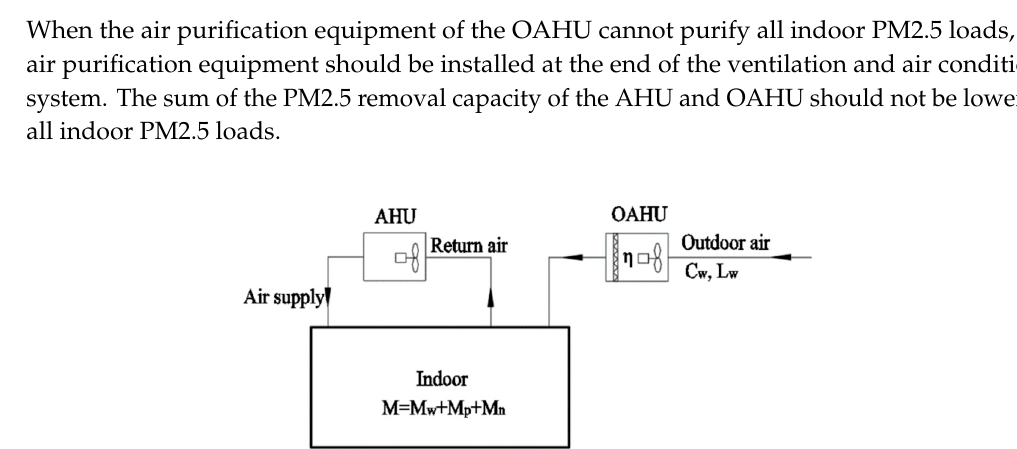
Figure 9. Schematic diagram of a semi-centralized system with outdoor air pretreatment and purifying indoor PM2.5 load.